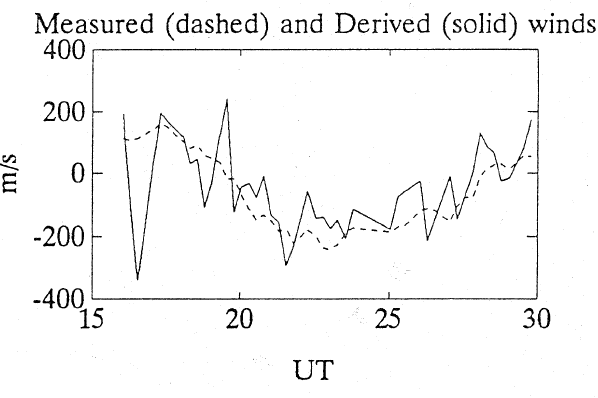
Fig. 8. Comparison of meridional winds directly measured by the FPI at Kiruna with those derived from EISCAT plasma velocities using the assumption of diffusive equilibrium. Data from the 21 st January 1990 show that under very particular conditions that may be tested statistically the derivation can be successful (from Davis, 1993).